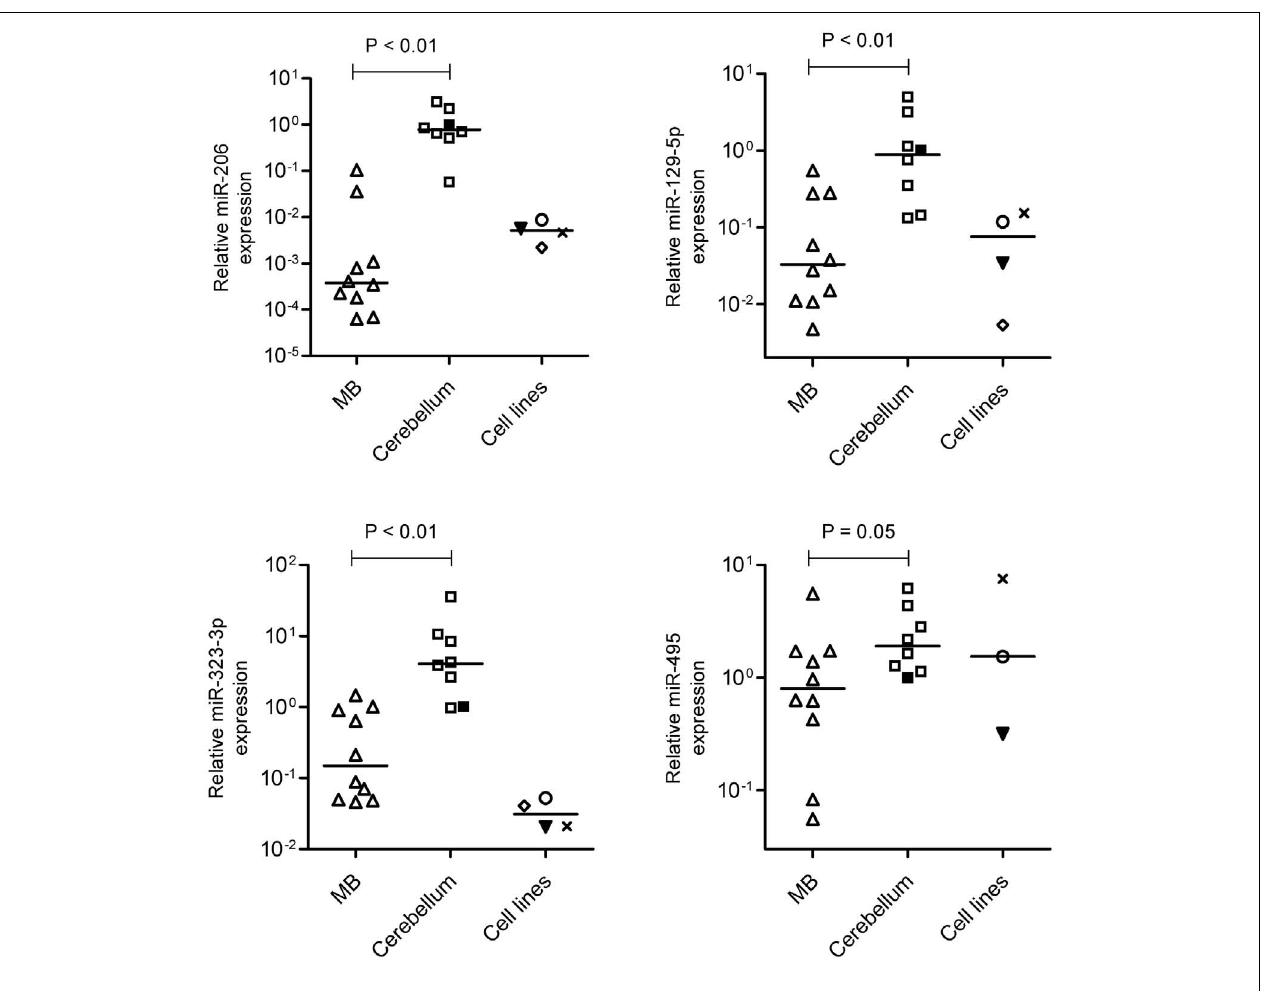
MB cell lines. Expression of miR-495 was not performed in D341 cell line. (cid:13) , DAOY; (cid:72) , Meb-Med-8A; x, D283Med; ♦ , D341. Comparisons of MB versus normal cerebellum were done by the Mann–Whitney test.